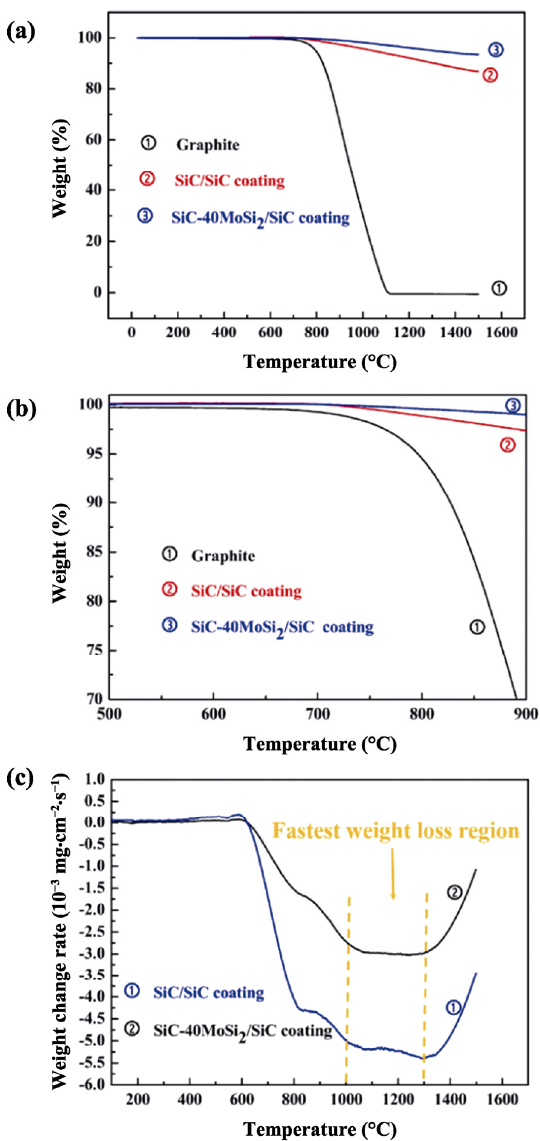
Fig. 5 (a) TGA curves of the samples from room temperature to 1500 ℃ ; (b) TGA curves of the samples from 500 to 900 ℃ ; (c) weight loss rate curves of the samples from room temperature to 1500 ℃